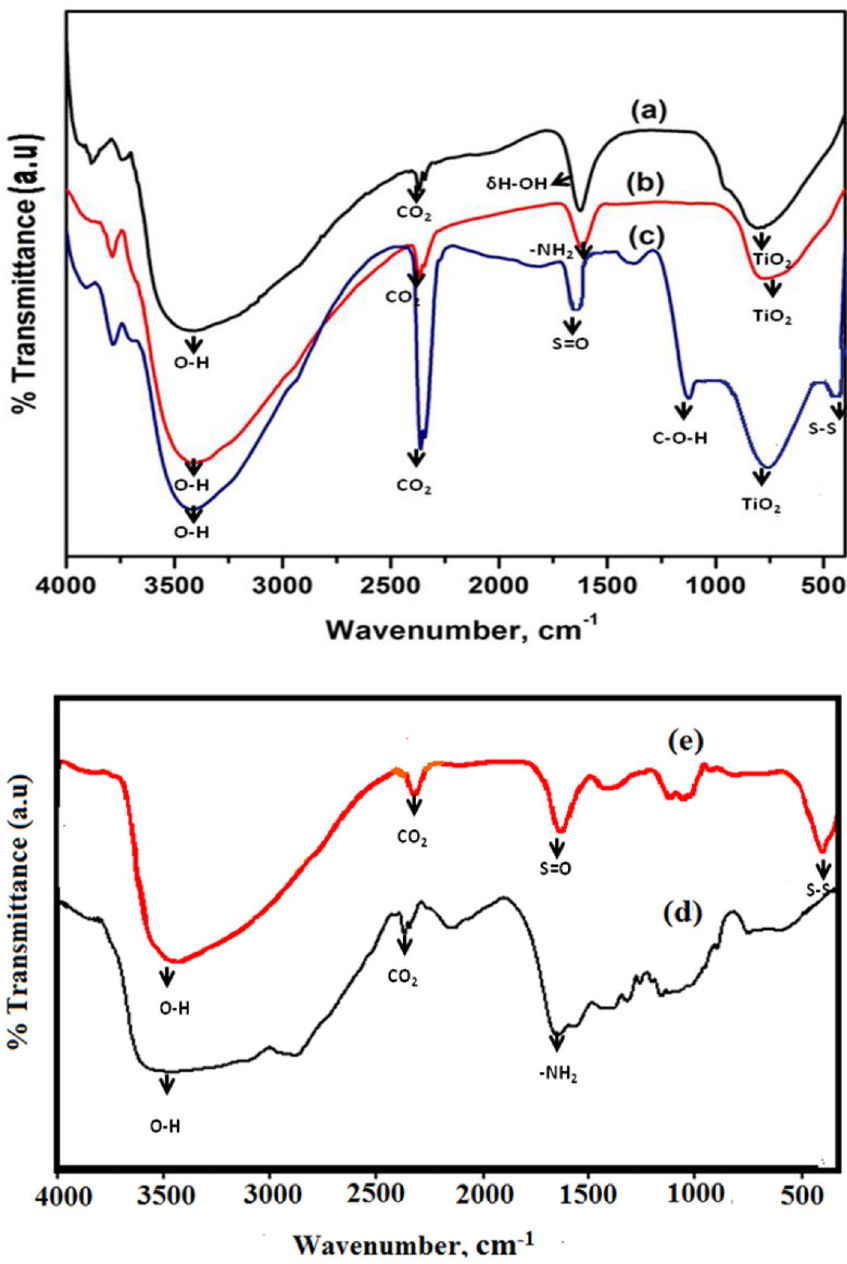
Figure 7. FT-IR of ( a ) CT ( b ) CS-CT ( c ) AS-CT nanocomposites ( d ) chitosan and ( e )